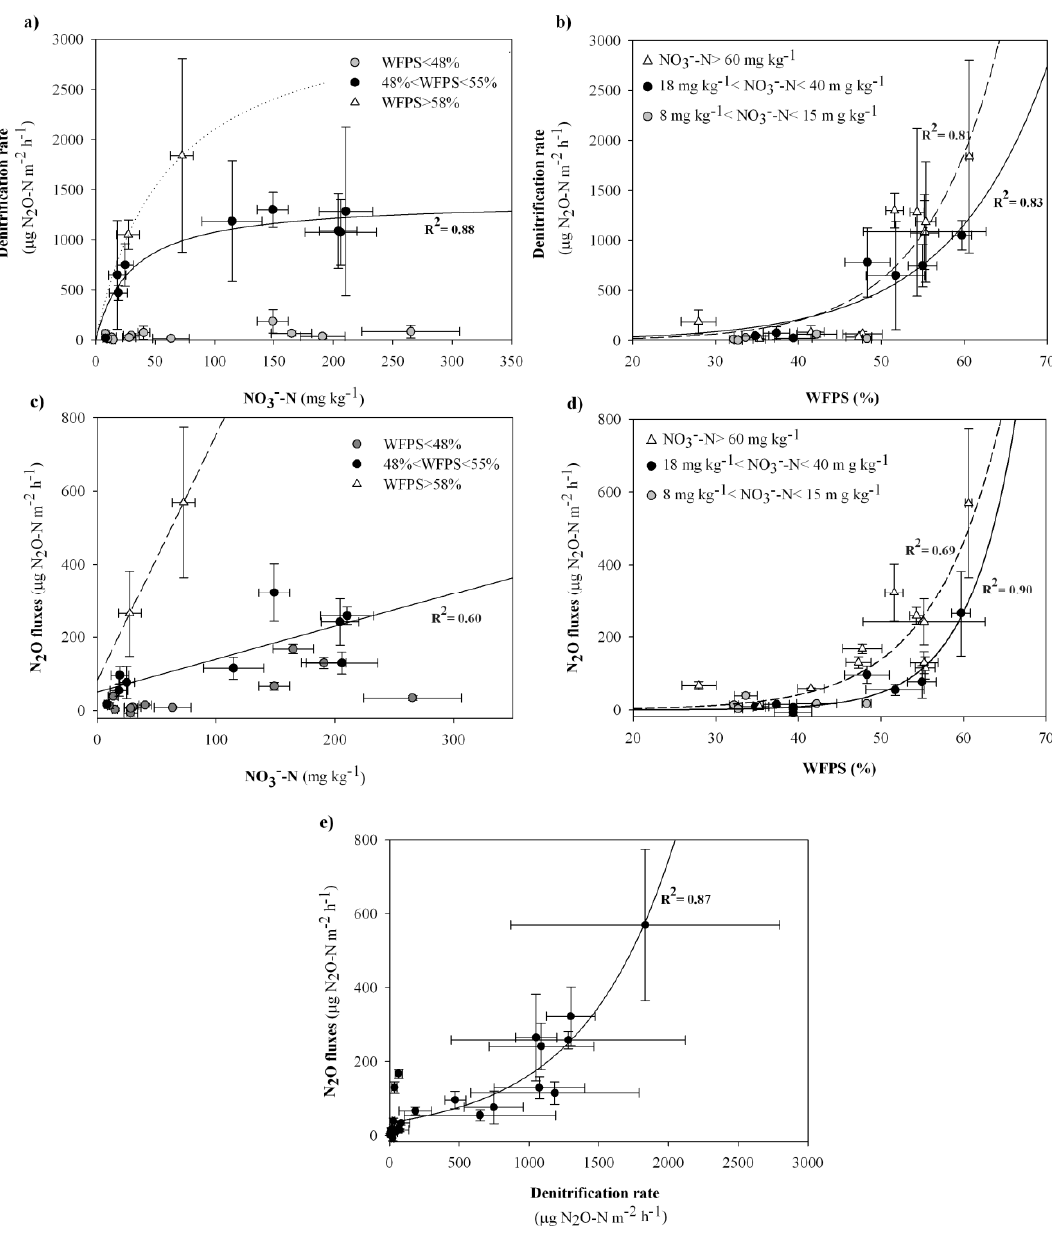
Figure 4. Analyses on the whole data set. All the figures refer to the mean values from each sampling date and R 2 is the coefficient of determination for the linear and non-linear fitting equations. (a) Denitrification rate vs. soil nitrate concentration at increasing range of soil WFPS (One site saturation equation, f= (Bmax*x)/(Km+x), where Bmax (maximum rate)= 1469.6 µg N 2 O-N m −2 h −1 and Km (half-saturation constant)= 38.5 mg NO 3− -N kg −1 ); (b) Denitrification rate vs. soil WFPS at increasing range of soil nitrate concentration (Exponential growth, 2 parameter equation, f= a*exp(b*x); a= 6.780 and b= 0.086 at 19 mg·kg −1 < NO 3− -N< 29 mg·kg −1 , solid line; a= 2.305 and b= 0.112 at NO 3− -N> 40 mg·kg -1 , dashed line); (c) N 2 O fluxes vs. soil nitrate concentration at increasing range of soil WFPS (Linear equation, f=y 0 +a*x, where y0= 50.37 and a= 0.90 at 40% < WFPS < 45%, solid line); (d) N 2 O fluxes from soil vs. soil WFPS at increasing range of soil nitrate concentration (Exponential growth, 2 parameter, equation, f= a*exp(b*x), where a= 0.32 and b= 0.12 at 19mg·kg -1 < NO 3− -N < 29 mg·kg -1 and a= 0,79 and b= 0,11 at NO 3− -N> 40mg·kg -1 ); (e) N 2 O fluxes from soil vs. Denitrification rate (Exponential growth, 2 parameter, equation, f= a*exp(b*x), where a= 35.8461 and b= 0.0015.